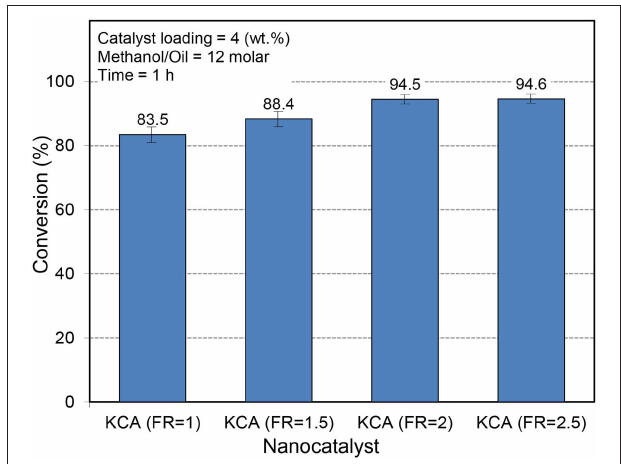
FIGURE 8 | Influence of fuel ratio on the catalytic performance of synthesized KOH/Ca 12 Al 14 O 33 nanostructured catalysts with various fuel ratios.